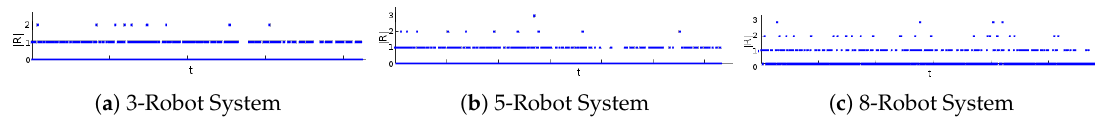
Figure 20. The maximum amount of unassigned robots time under different sized multi-robot systems. All images concern instances of AAMO set with HO-Threshold = 15. Blue dots represent the the exploration.